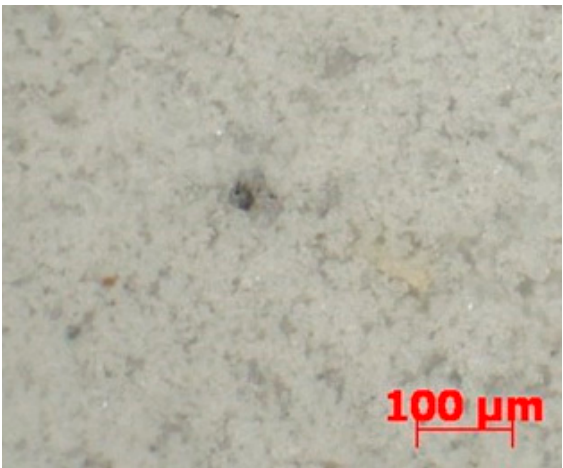
Table 2. PG oxide chemical composition.